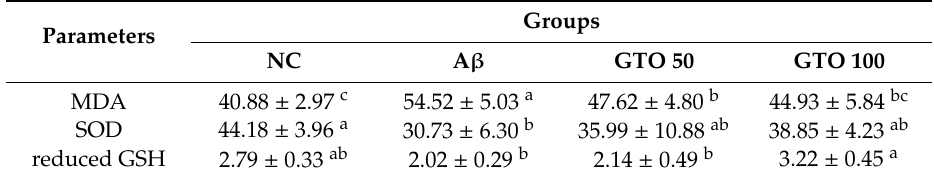
Table 2. Protective e ff ect of green tea seed oil (GOT) on A β -induced biochemical changes related to the antioxidant